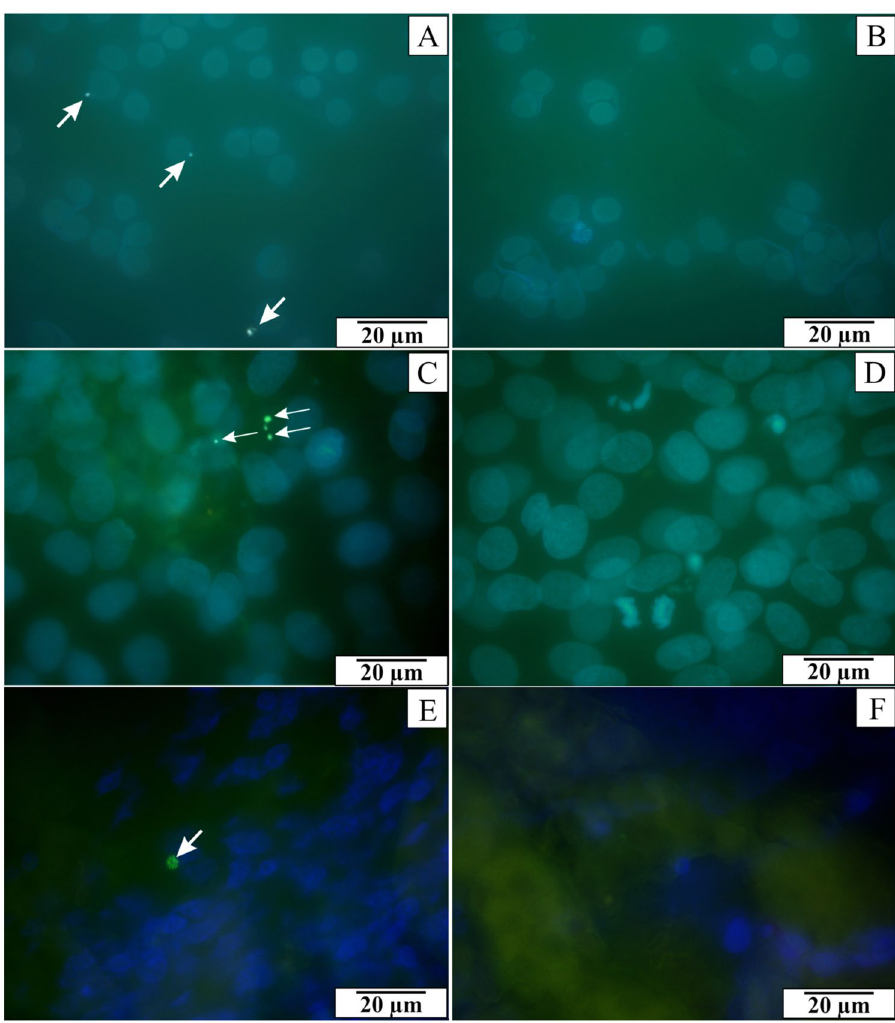
Figure 2. Fluorescent in situ hybridization. ( A ) blood smear of rats infected with B. microti . ( B ) blood smear of rats from control group. ( C ) rats’ kidney epithelial cells (NRK-52E cells) cultured with blood collected from infected rats. ( D ) control NRK-52E cells. ( E ) kidney collected from rats infected with B. microti . ( F ) kidney collected from control rats. Arrows in figures ( A , C , E ) indicate green spot signals of fluorescence which confirm the presence of B. microti genetic